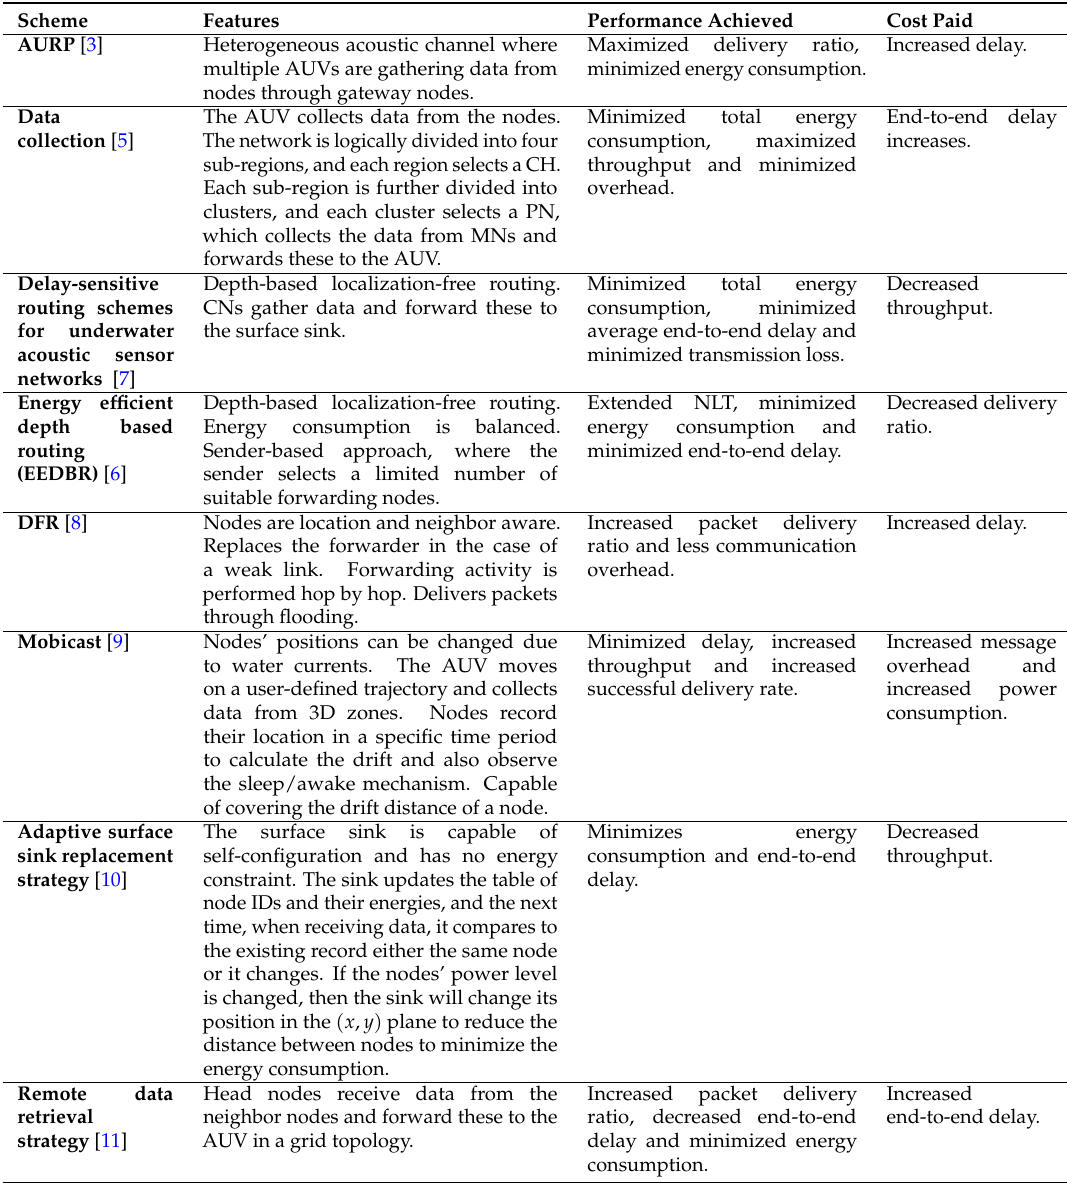
Table 2. Overview of existing protocols. AURP, AUV-aided underwater routing protocol; PN, path node; MN, member node; NLT, network lifetime; DFR, directional flooding-based